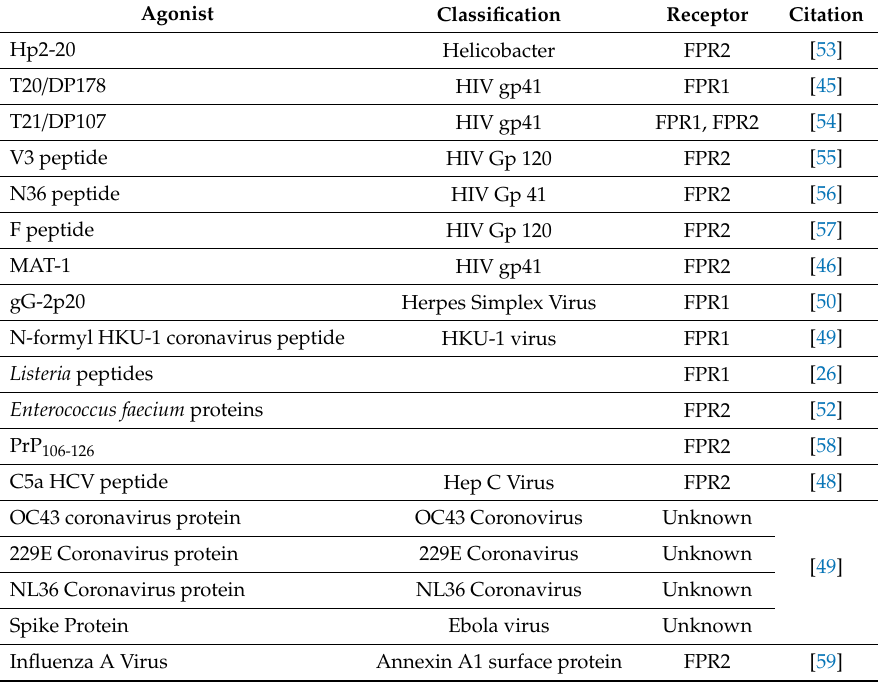
Table 3. Microbe-derived peptide ligands for FPRs